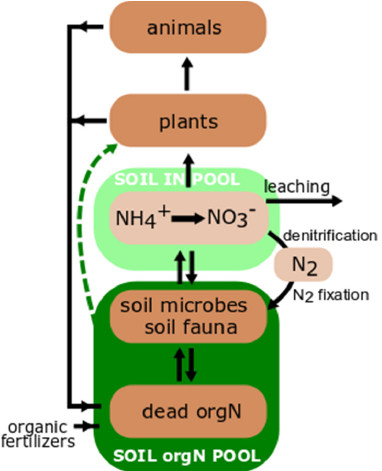
Figure 1. Nitrogen (N) cycle: pools and fluxes. Potential use of organic N pool marked in dashed green line. IN—inorganic N, orgN—organic N.